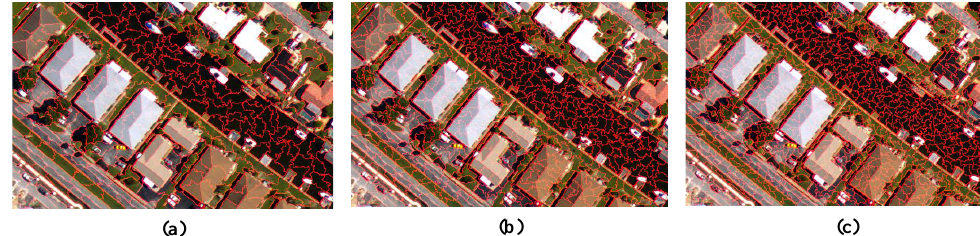
Figure 2. Superpixel segmentation map: ( a ) Superpixel number is 500. ( b ) Superpixel number is 1000. ( c ) Superpixel number is